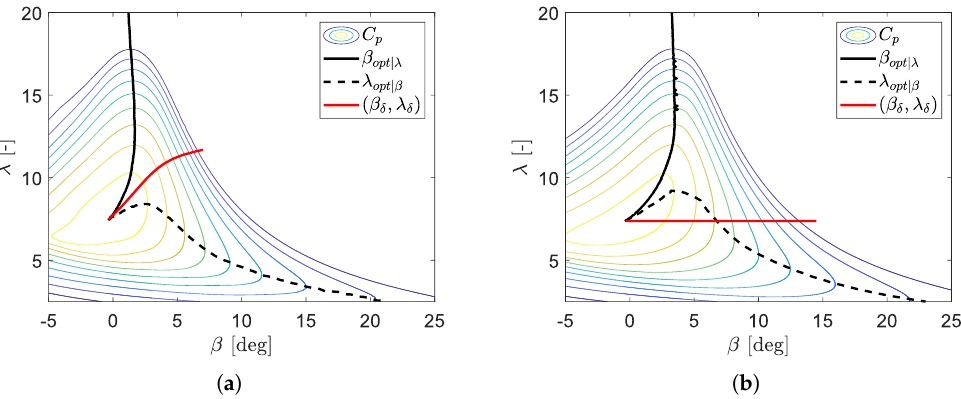
Figure 7. Power coefficients of NREL 5-MW ( a ) and DTU 10-MW ( b ) reference turbines.